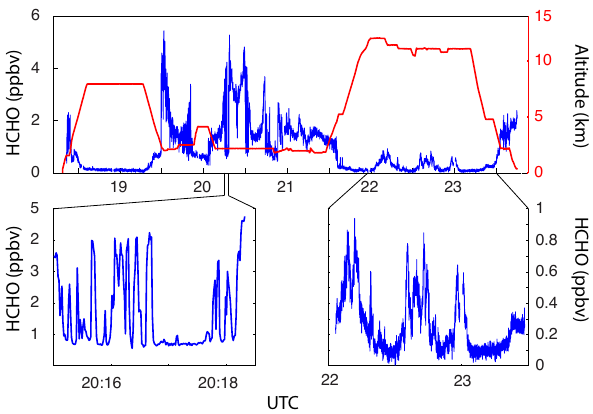
Figure 11. In situ measurements of HCHO are shown for the flight of 2 June on the NASA DC-8 during the Deep Convective Clouds and Chemistry (DC3) campaign in 2012. The top shows 1s HCHO and GPS altitude. The lower portions are expanded views of the boundary layer (BL) leg and the upper tropospheric (UT) leg. The fast response to large changes in ambient HCHO are evident in the BL leg. The sensitivity (better than 20pptvs − 1 ) is evident in the UT leg.